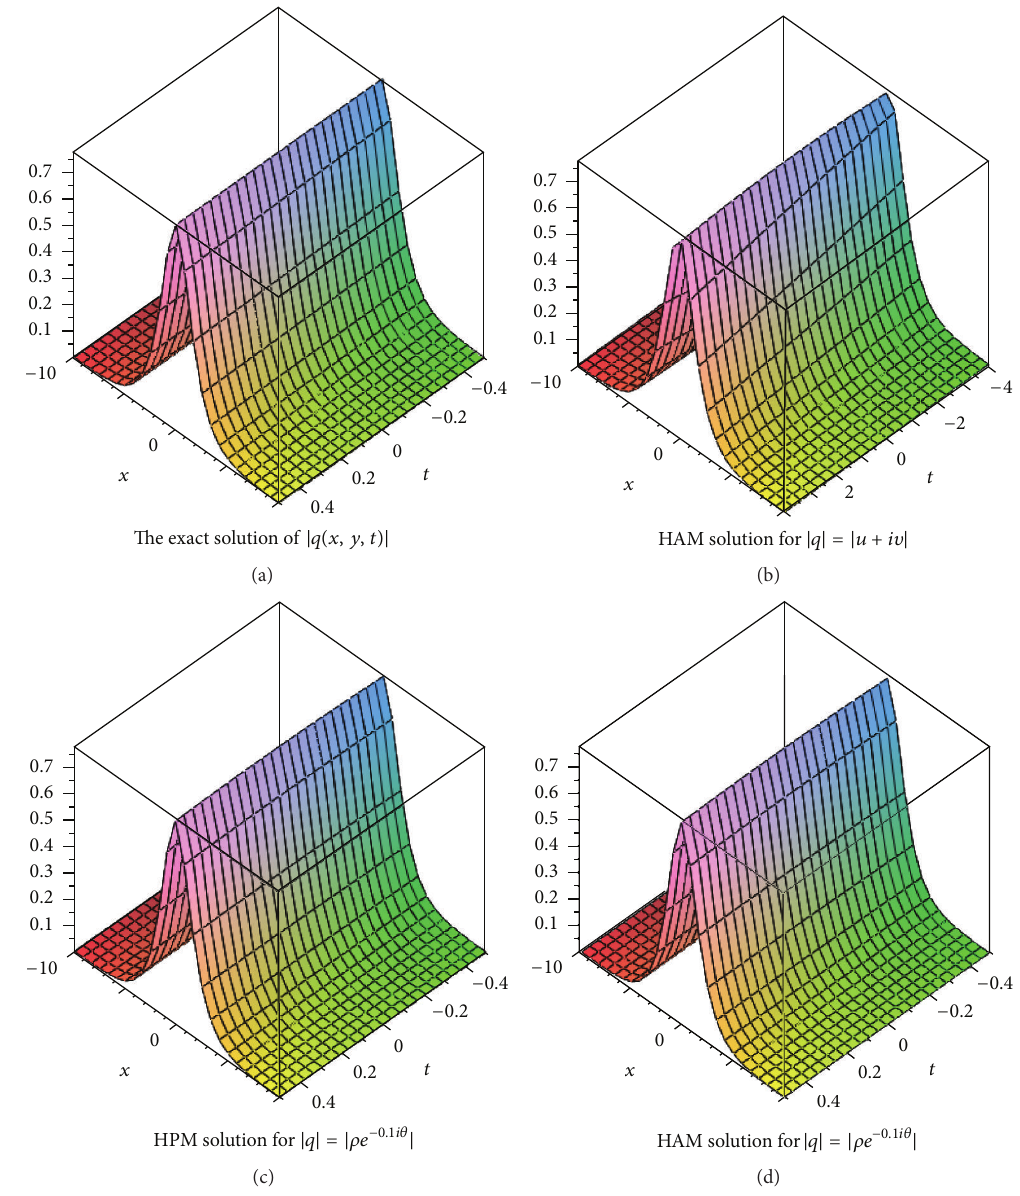
Figure 1: Comparison between the exact solution, the HPM solution, and the HAM solution for 𝑞(𝑥,𝑦,𝑡) .